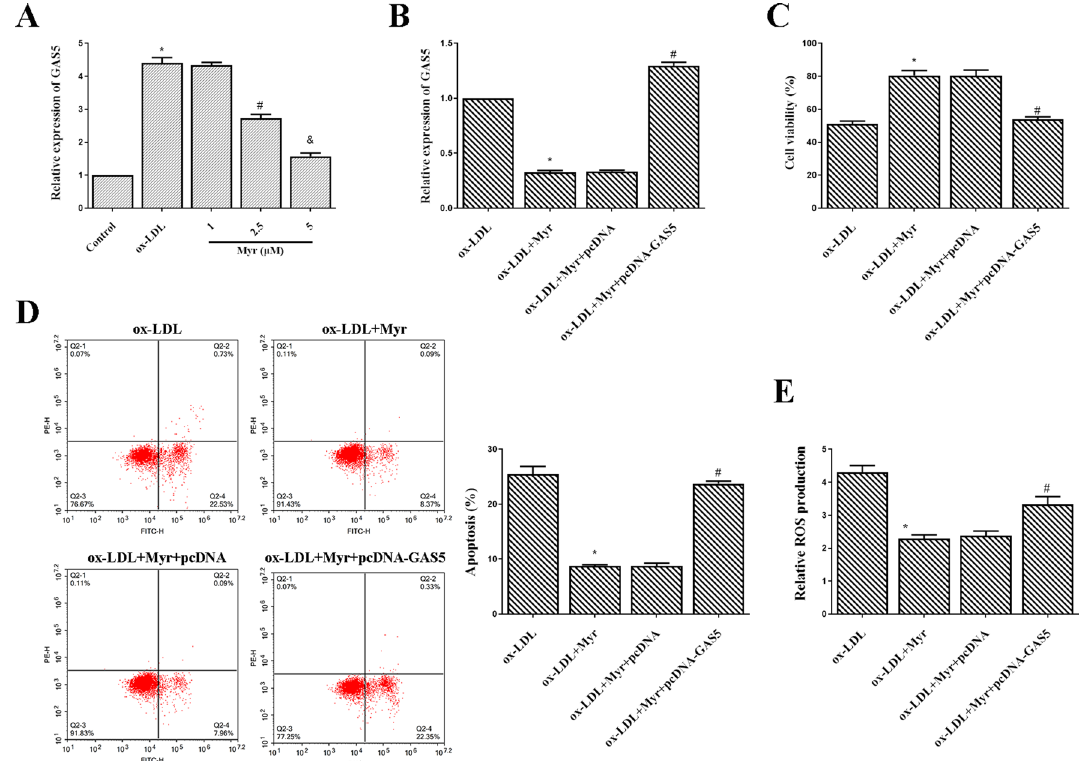
Figure 3. GAS5 over-expression attenuates Myr protective effects against ox-LDL–mediated HUVEC injury. ( A ) GAS5 expression was determined with qRT-PCR. HUVEC cells were pre-incubated with 1/2.5/5 μM Myr for 2 h and then stimulated with or without 100 μg/mL ox-LDL for 24 h. * P < 0.05 compared with control; # P < 0.05 compared with ox-LDL; & P < 0.05 compared with 2.5 μM. ( B ) qRT-PCR analysis of relative